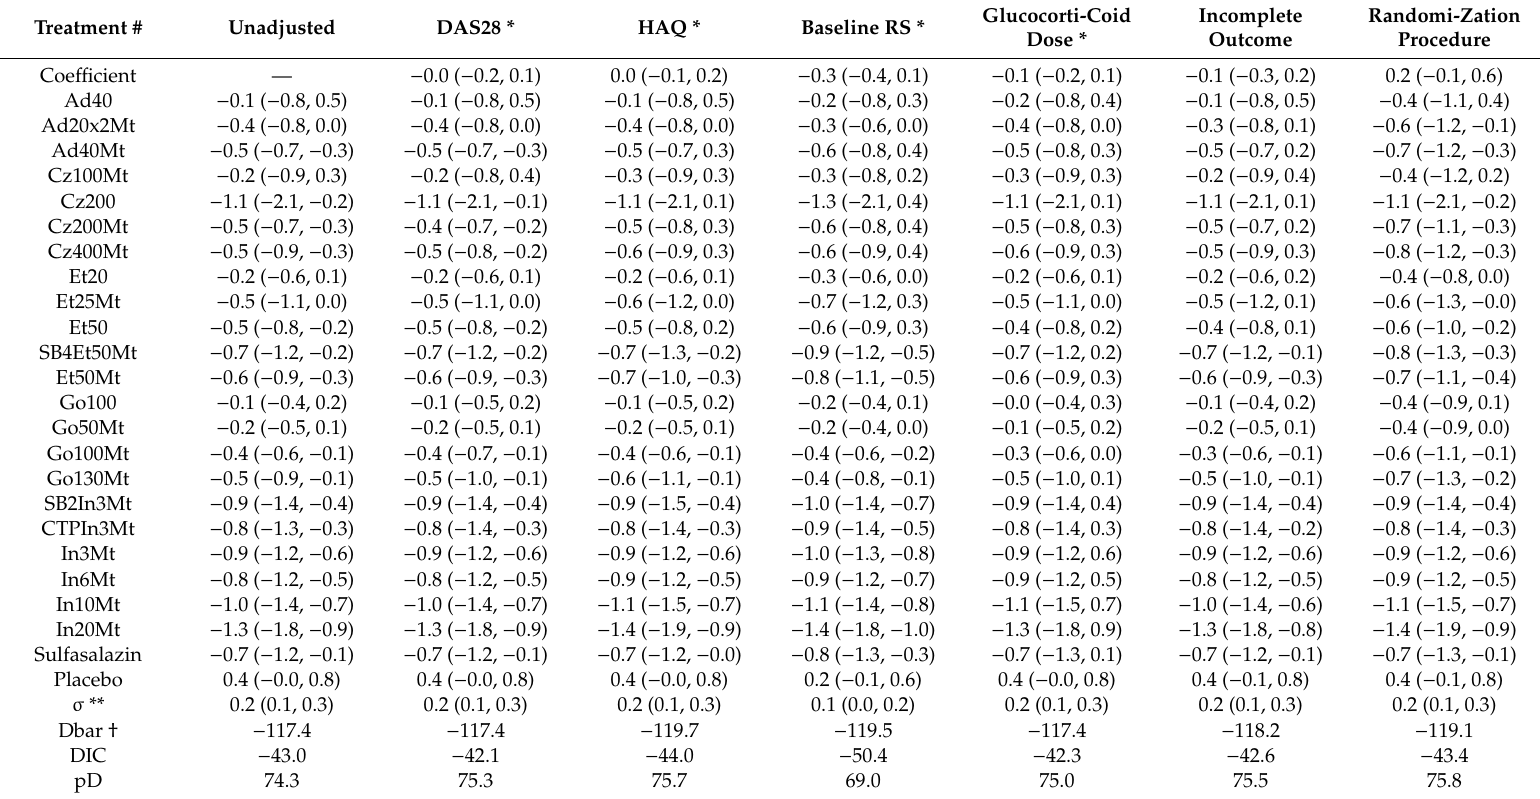
Table 2. Random-e ff ects regression analyses with one covariate at a